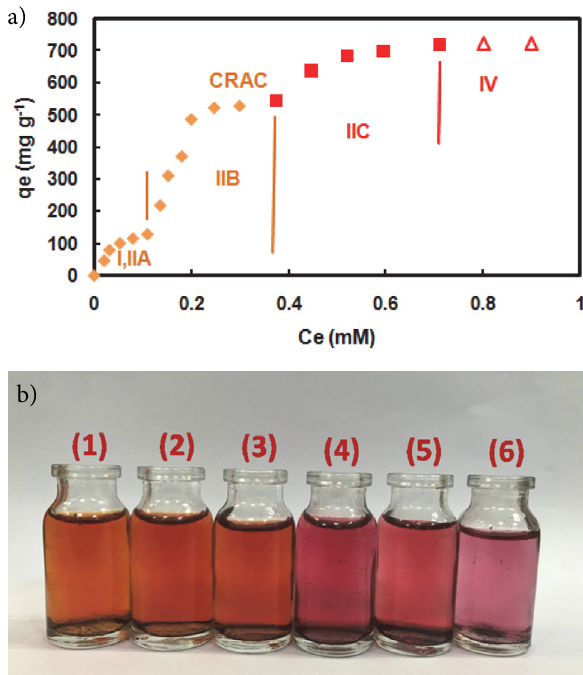
Figure 8. (a) Adsorption isotherm of ARS on GO/PAMAM at pH = 5 which showed adsorption of ARS – molecules on Ph (region I) and –NH + 3 (region IIA) sites and ARS 2– molecules on –NH + 3 (region IIB) sites, respectively. (b) Solutions in bottles 1-3 belonged to re- gions I, IIA and the second CRAC. Solutions in bottles 4-6 belonged to region IIB and initial ARS concentrations increased from bottles 1 to